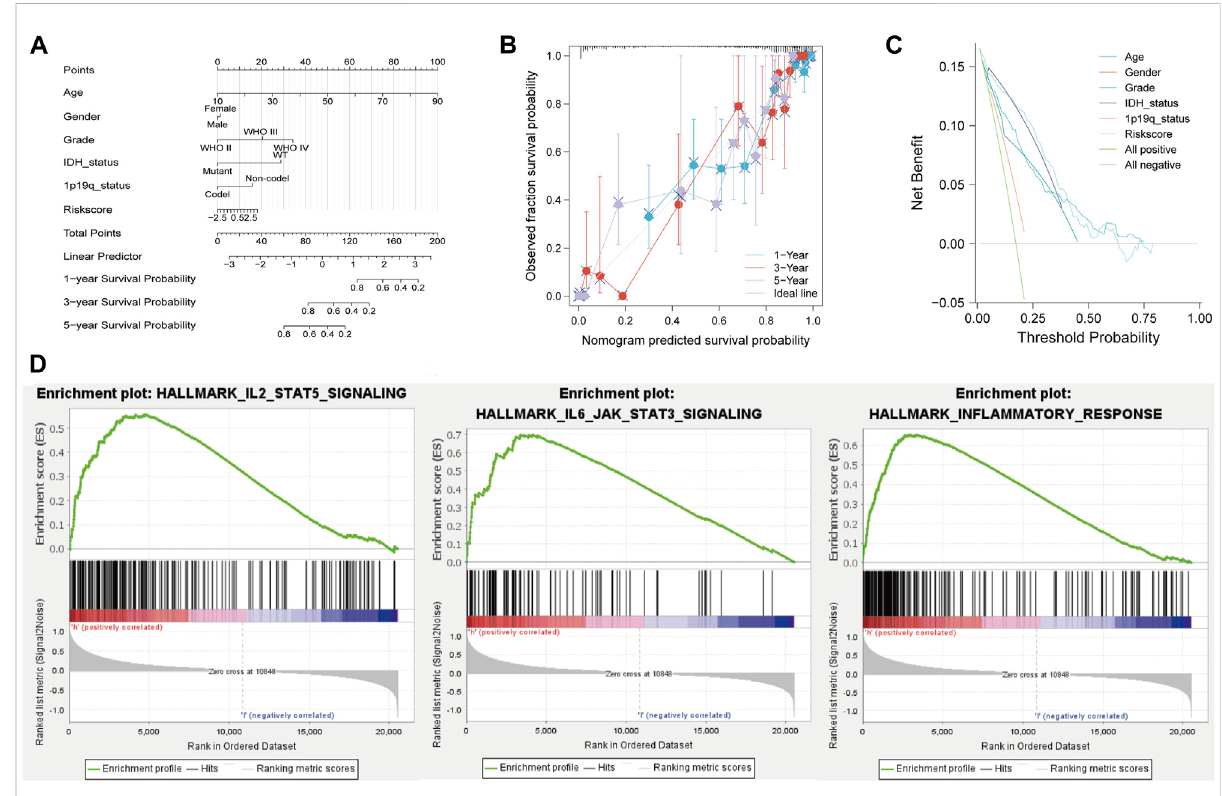
FIGURE 5 NomogramandGSEAanalysisoftheTCGAdatabase. (A) Prognostic nomogram. (B) Calibrationplotof1-,3-,and5-year. (C) DCAand (D) GSEA of the high- and low-risk score groups. Normal p -value < 0.05 (NOM p-Val) were considered signi fi